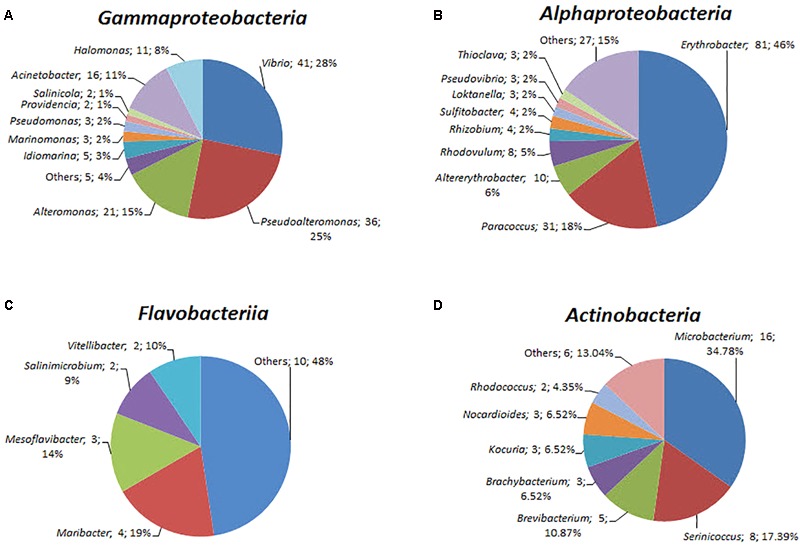
The diversity of the bacterial isolates. (A) Gammaproteobacteria, (B) Alphaproteobacteria, (C) Flavobacteriia, and (D) Actinobacteria. Each color represents the percentage of the taxon in the total isolates.